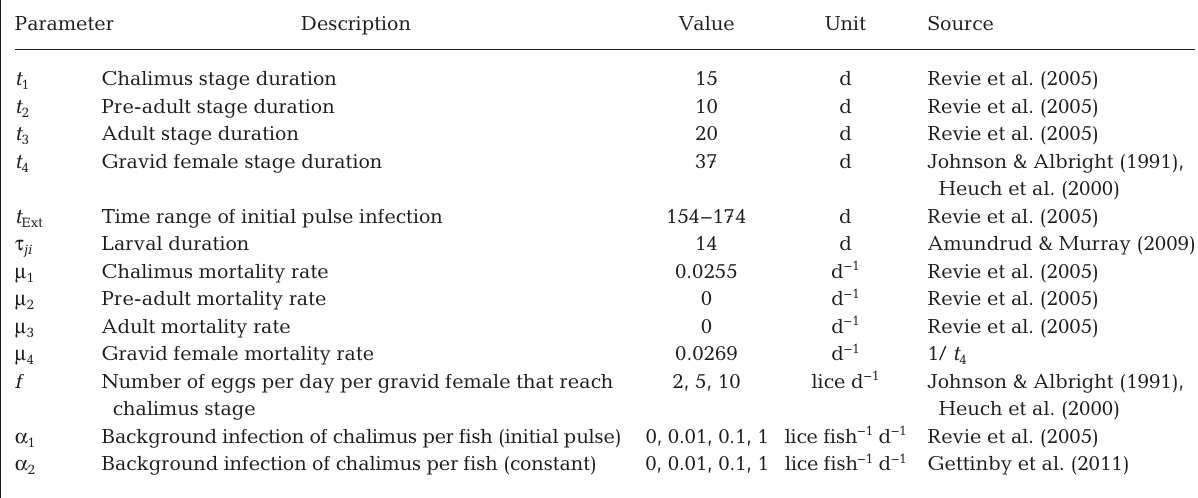
Table 1. Model parameters. Life stage duration parameters of salmon louse Lepeophtheirus salmonis follow those of Revie et al. (2005) and approximate values estimated by Stien et al. (2005) at 10 to